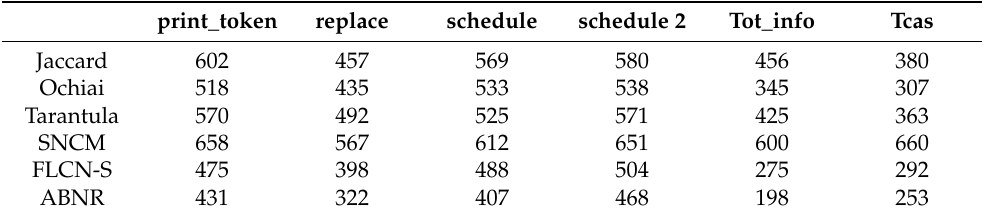
Table 6. Denote the number of statements analyzed for fault detection from Siemen’s validation set.